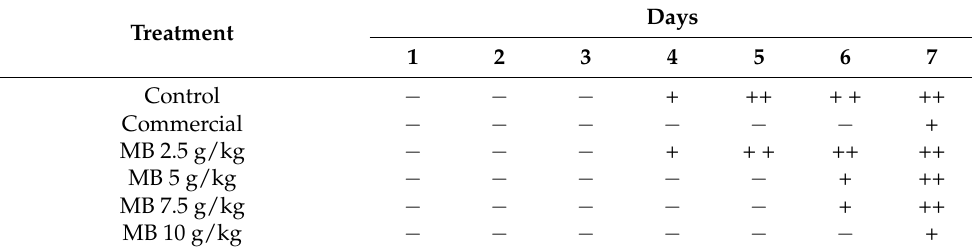
Table 4. The shelf life of bread loaves formulated with white mustard bran (MB) at 2.5, 5, 7.5, and 10 g/kg. The control did not receive treatment, and the commercial treatment was performed with sodium propionate (E-281) at 2 g/kg. The bread was contaminated with P. commune CECT 20767.